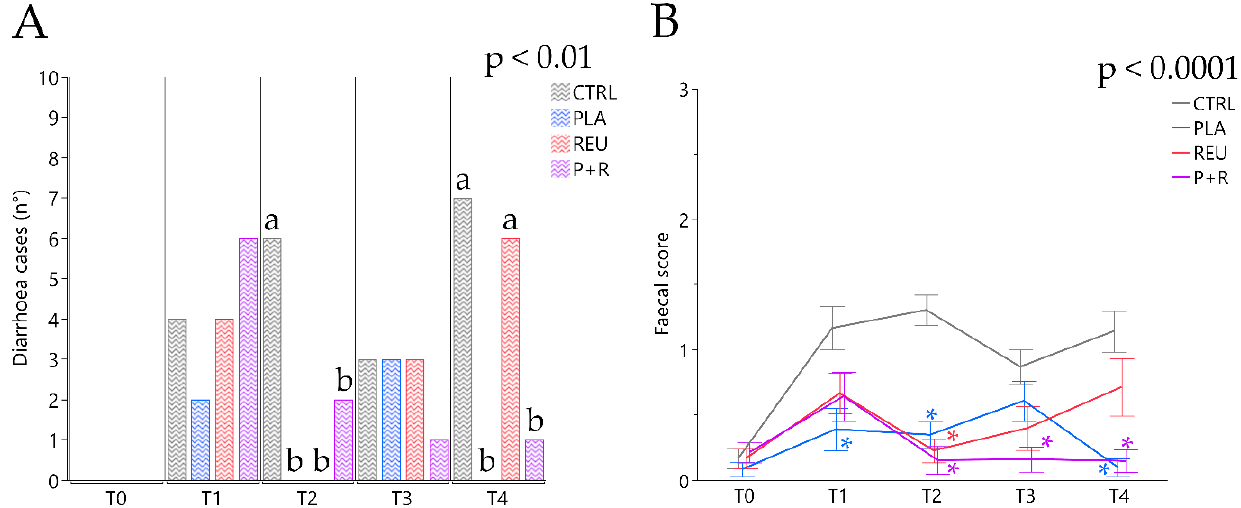
Figure 5. Number of diarrhoea cases recorded ( A ) and average faecal scores ( B ) during the 28-day trial for the control (CTRL) and treatment groups (PLA, REU and P+R). ( A ) Data are expressed as the sum of the recorded cases of diarrhoea, considering faecal score ≥ 2 diarrhoea; a,b Means with different superscripts are significantly different among treatments ( p < 0.01). ( B ) Data are expressed as least square means (LSMEANS) and standard errors (SE); * Means with asterisks are significantly different from the control group (CTRL, p < 0.0001). CTRL: control group; PLA: treatment group supplemented with 2 × 10 8 CFU/g of L. plantarum ; REU: treatment group supplemented with 2 × 10 8 CFU/g of L. reuteri ; P+R: treatment group supplemented with 2 × 10 8 CFU/g of L. plantarum and L. reuteri (1:1, w / w